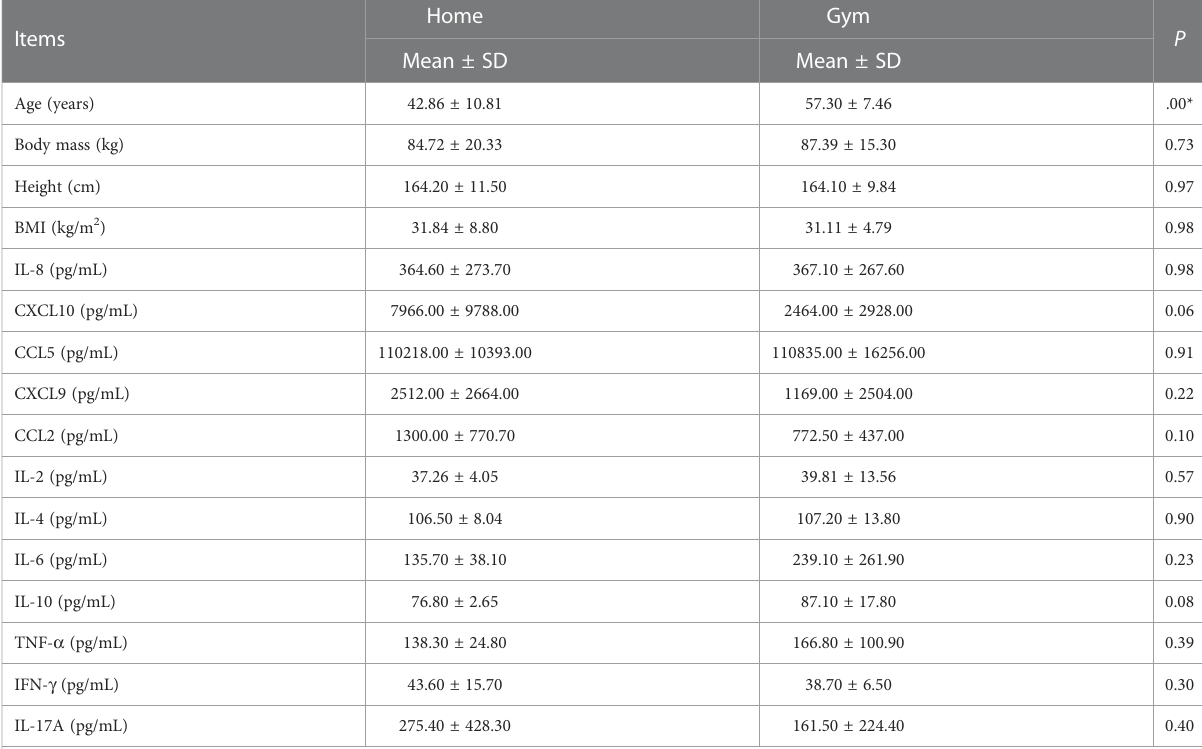
TABLE 1 Baseline characteristics of patients in both